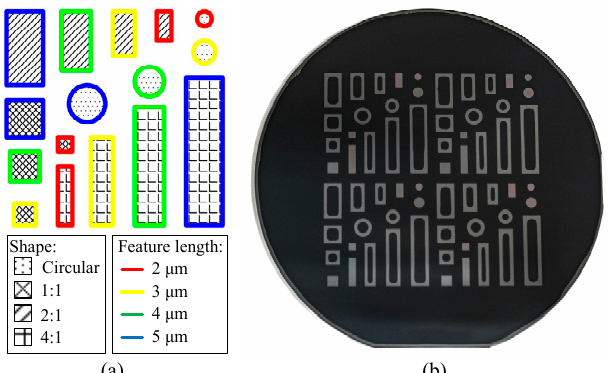
Figure 5. Verification experiment on the pull-in effect. ( a ) Design of etching patterns on silicon wafers and ( b ) an example image ( d : 2 μ m, h : 400 μ m) of the seven pull-in effect results. The patterns with dark fillings indicate the occurrences of the pull-in effect.